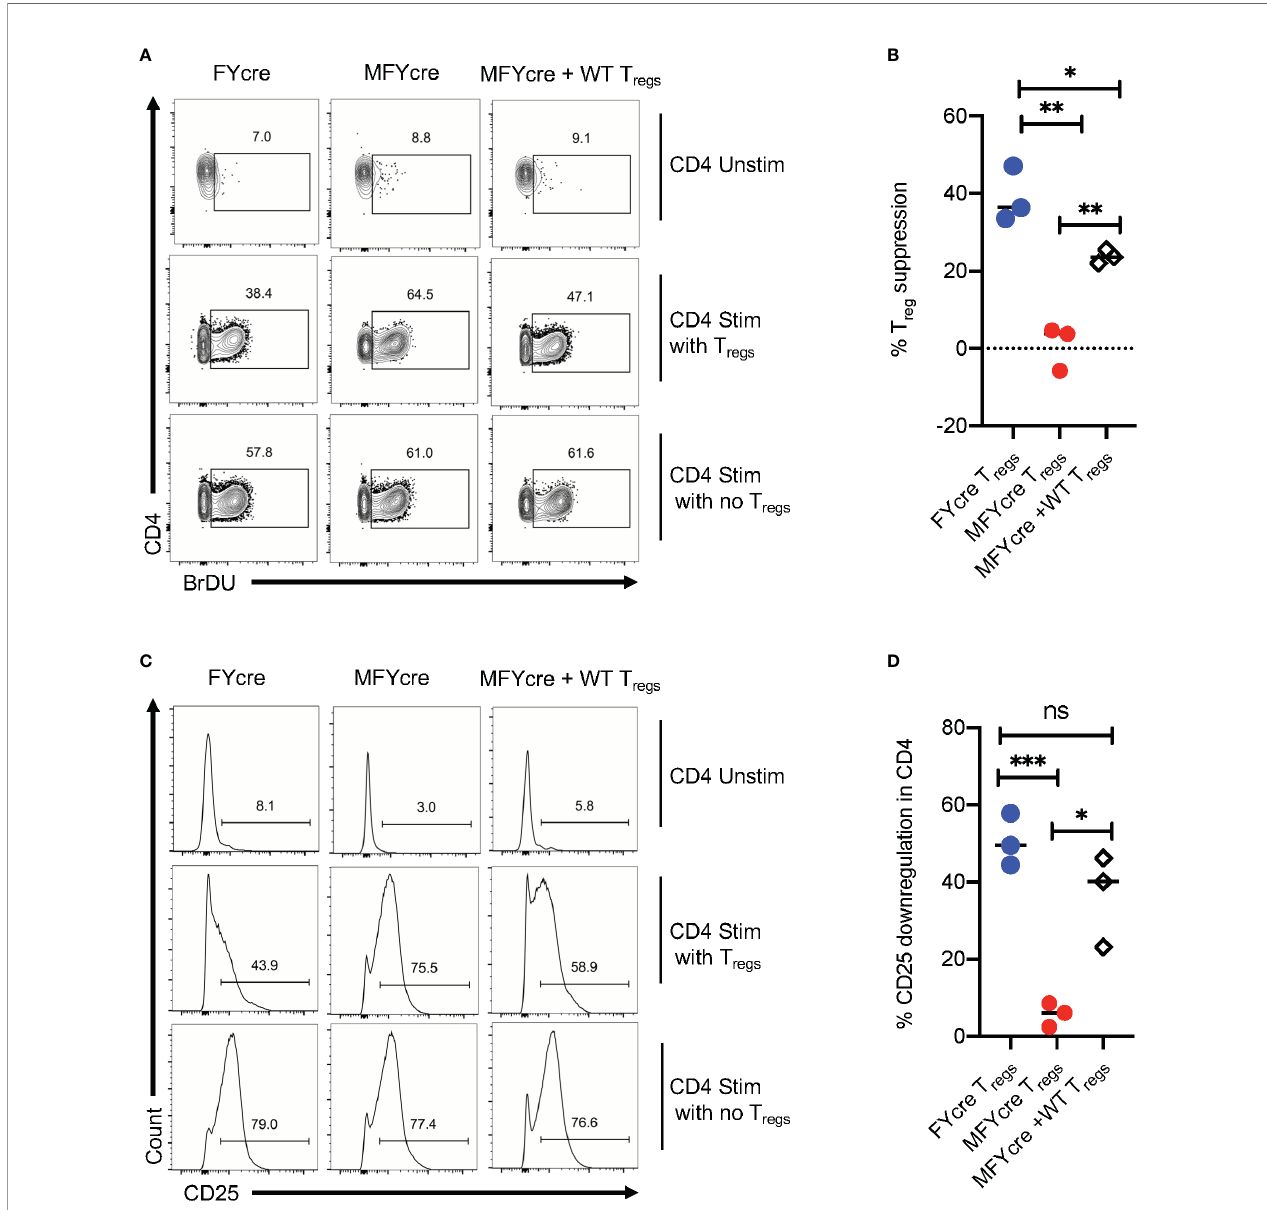
FIGURE 4 | CD25 + Foxp3 + cells lacking MyD88 in infected mice lack suppressive functions in vitro . FYcre and MFYcre mice were infected with sham control or CA as in Figure 2 (n= 4 – 6/group). On day 6 after infection, cells from cervical lymph nodes (CLN) and mouse oral intra-epithelial and lamina propria leukocytes (MOIL) of FYcre + CA, MFYcre + CA and MFYcre + CA +T regs groups were collected for in vitro stimulation with a -CD3 and a -CD28 antibodies (CD4 Stim with T regs ) for 3 – 4 days. Some cells each mouse group were stimulated after the removal of CD4 + CD25 + T regs (CD4 Stim with no T regs ). A control culture was plated with no restimulation (CD4 Unstim). BrDU was added in the last 24 h before harvesting the cells for fi xation and fl ow cytometry for BrDU (A, B) and CD25 (C, D) . Flow cytometry gating excluded Foxp3 + T reg cells in cultures. T reg suppression was measured by % BrDU+ proliferating cells as normalized to “ CD4 Stim with no T regs ” cultures. Mean values ± SEM from 3 independent experiments are plotted. * P< 0.05; 2 way ANOVA and Unpaired 2-tailed students “ t ” tests. **P < 0.005, ***P < 0.0005. NS, non-signi fi